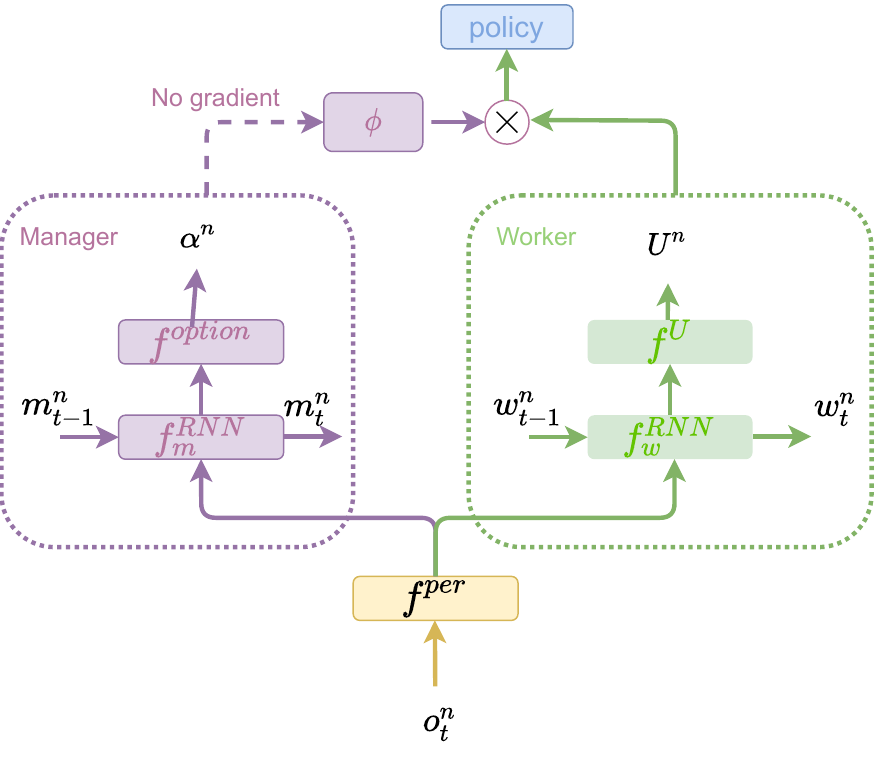
Figure 1. The structure of the hierarchical model takes the agent’s current observation as input and output a policy that is a distribution over available actions. There are two levels, i.e., the manager and the worker, in the model and marked in purple and green,